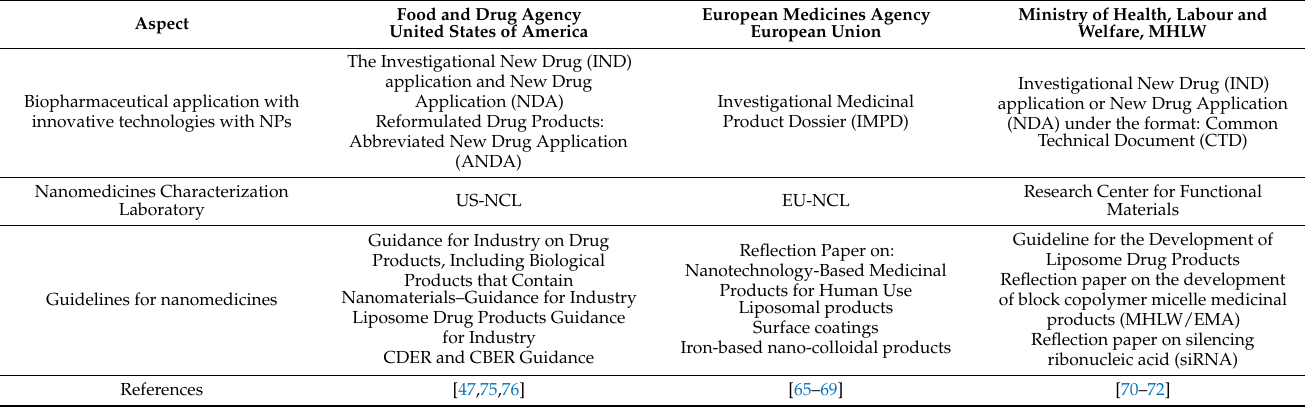
Comparative table with main regulatory agencies and their regulatory progress in